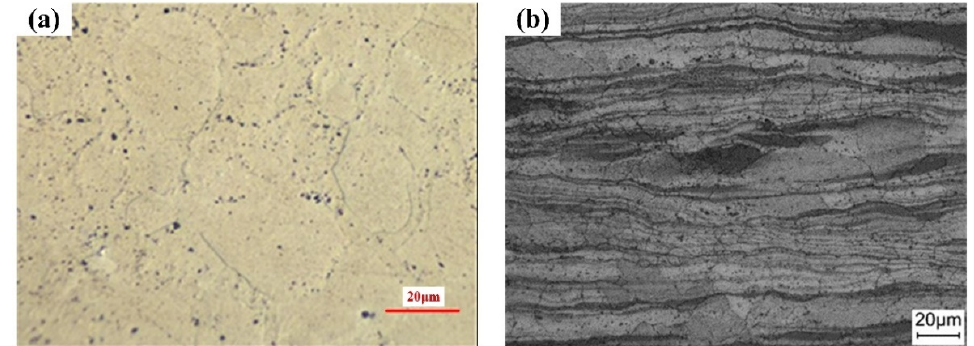
Figure 2. ( a ) Metallographic structure and ( b ) SEM of original ZK61M alloy from ND.